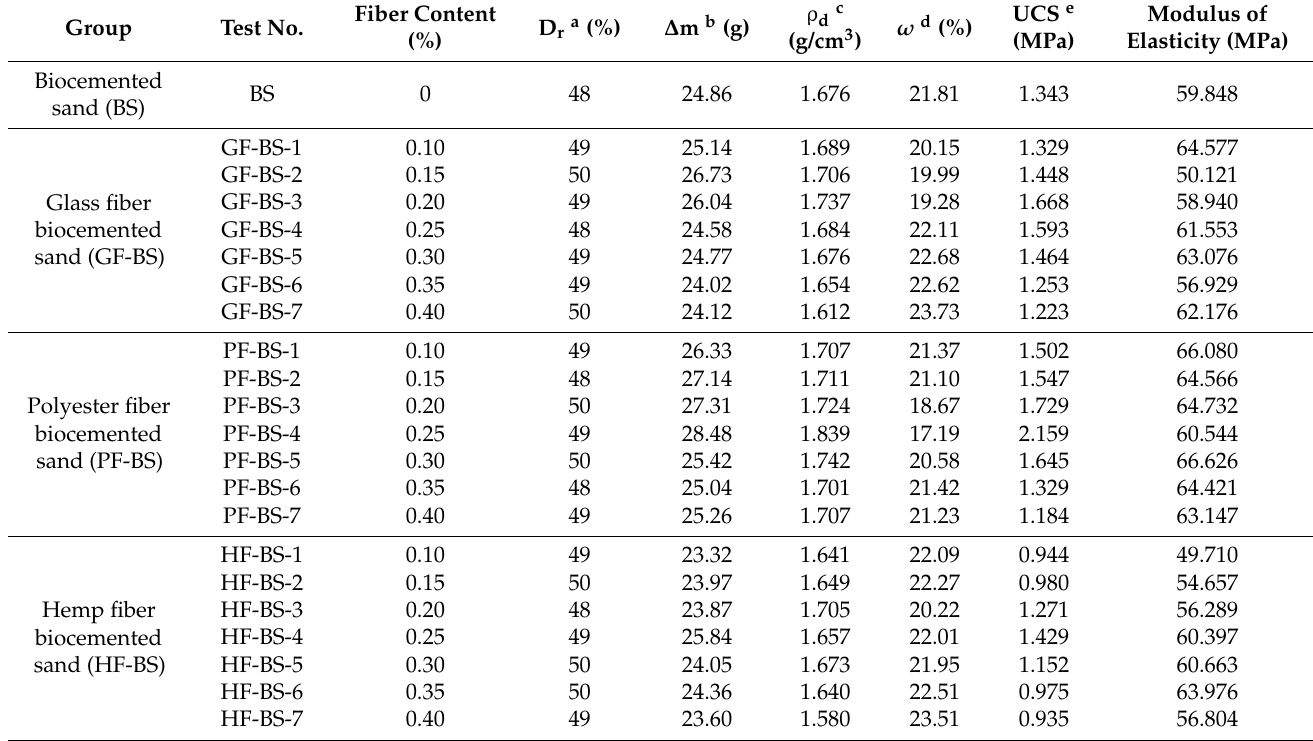
Table 3. Test results of the biocemented sands with different fiber types and